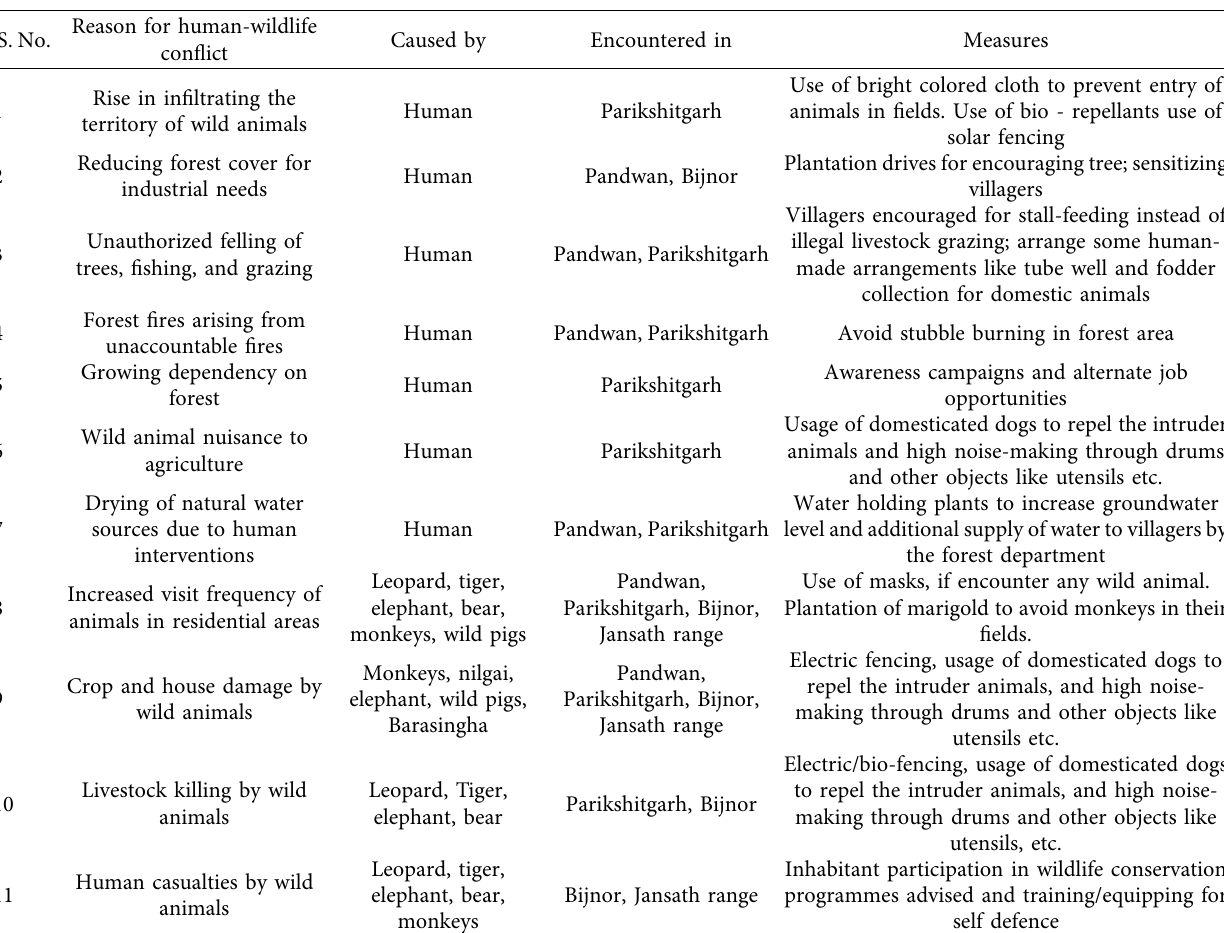
Table 2: Table summarizing the site-wise human-wildlife confict in Hastinapur wildlife sanctuary and measures. Reason for human-wildlife S. No.